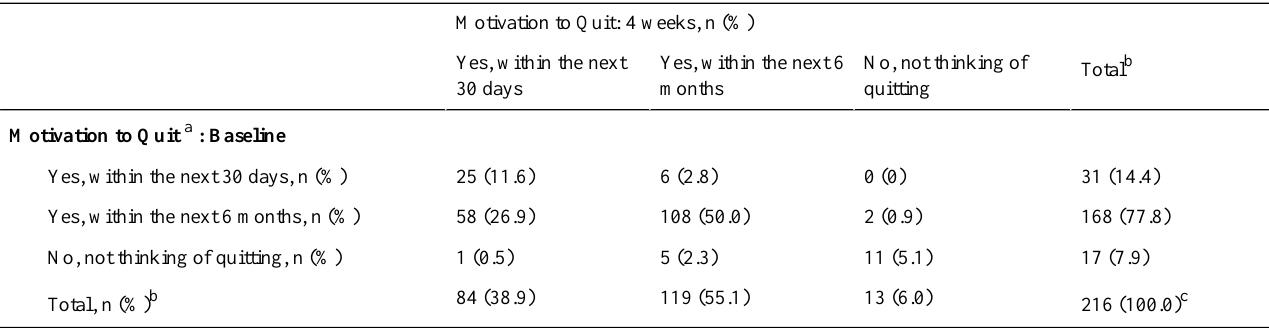
Table 4. Change in motivation to quit smoking (N=216) at baseline (rows) versus 4 weeks (columns). Motivation to Quit: 4 weeks, n